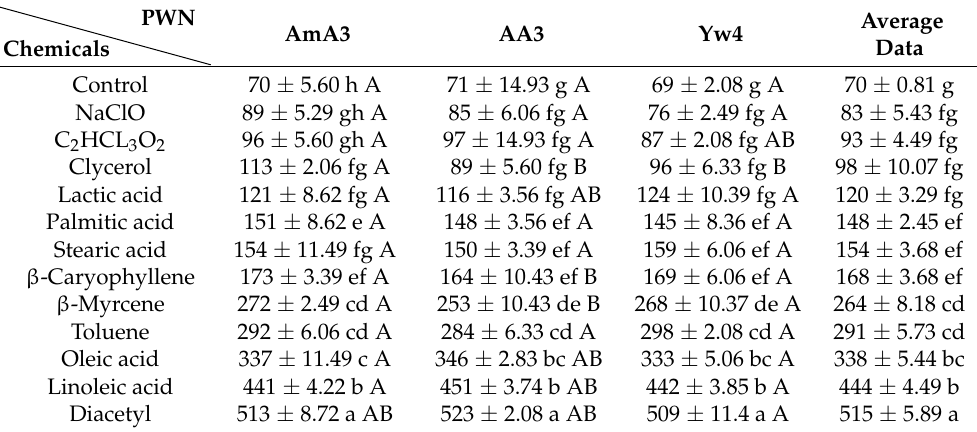
Table 2. Attractive effects of different chemicals toward different PWN